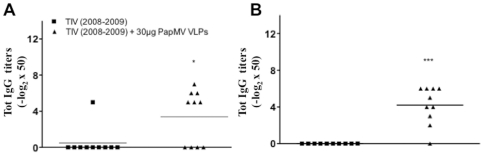
PapMV nanoparticles increase the breadth of the humoral response directed towards TIV (2008–2009).Balb/C mice (10 per group) were immunized once with 1/5 of the human dose of TIV (2007–2008) alone or with 30 µg PapMV nanoparticles. A, Total IgG directed towards intact virion of influenza strain WSN/33. B, Total IgG directed to intact virion of the strain A/Kentucky/91 (H3N8). * p< 0.05 and *** p< 0.001.